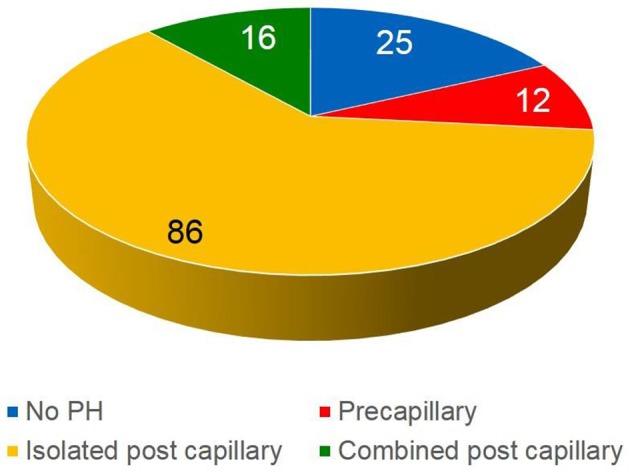
Classification of the patient population (n = 139).